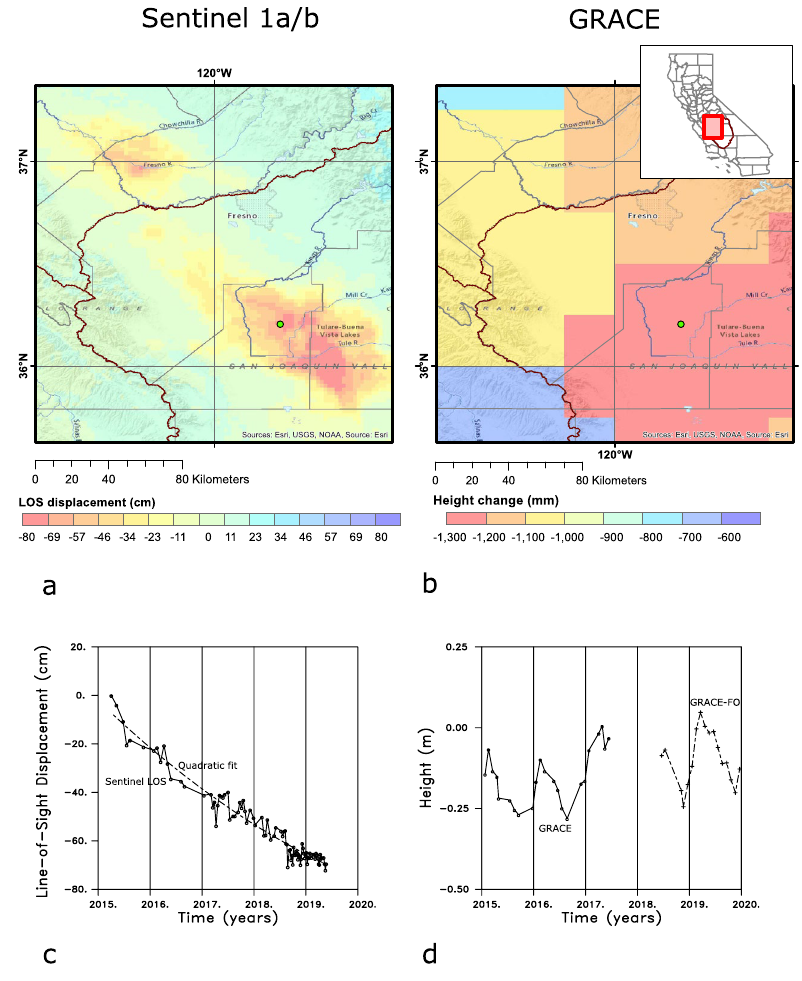
Figure 2. ( a ) Sentinel 1a/b Interferometric Synthetic Aperture Radar (InSAR) cumulative line-of-sight displacement from May 2015 until January 2019, for the area surrounding the Tulare basin. The filled green circle denotes the location used to calculate the InSAR line-of-sight displacements in panel c and in Fig. 3. ( b ) GRACE estimates of mass concentrations for 0.25 by 0.25 degree patches in the Tulare basin region, calculated in terms of an equivalent change in water height for the period 2011 to 2019. ( c ) Line-of-sight displacement time series for a point located midway between Lemoore and Corcoran. The solid curve and open circles denote displacements relative to early 2015 while the dashed curve represents a quadratic fit to the time series. ( d ) Area- wide average change in equivalent water height from 2015 until 2020 for the original GRACE satellite (solid line, open circles) and the subsequent GRACE follow-on (GRACE-FO) mission (dashed line, pluses). The average corresponds to the total change in water height over the mascons in the area of interest divided by the number of mascons in the region. The two maps in panels ( a ) and ( b ) were created with ESRI ArcMap 10.8.1 software (https:// www. esri.